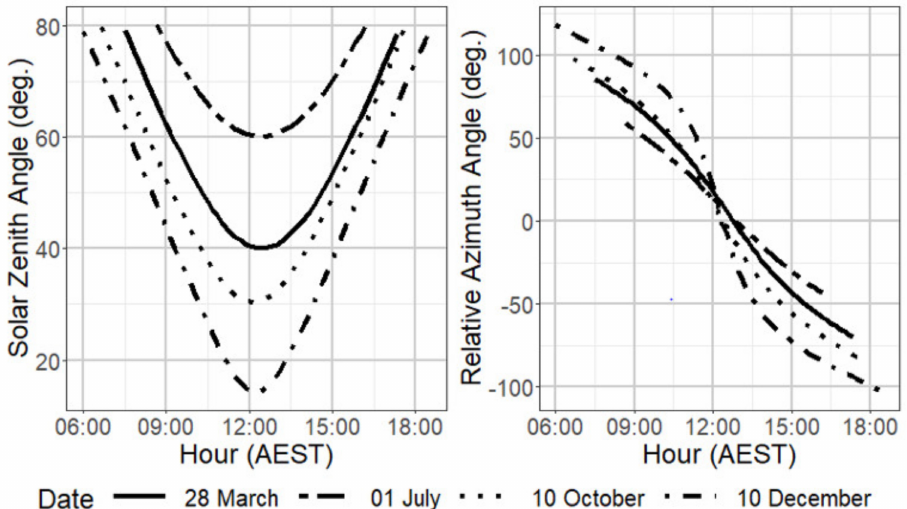
Figure 4. Diurnal and seasonal variations in solar zenith angles ( left ) and relative azimuth angles ( right ) for four seasonal times of the year at the Redesdale grassland pasture